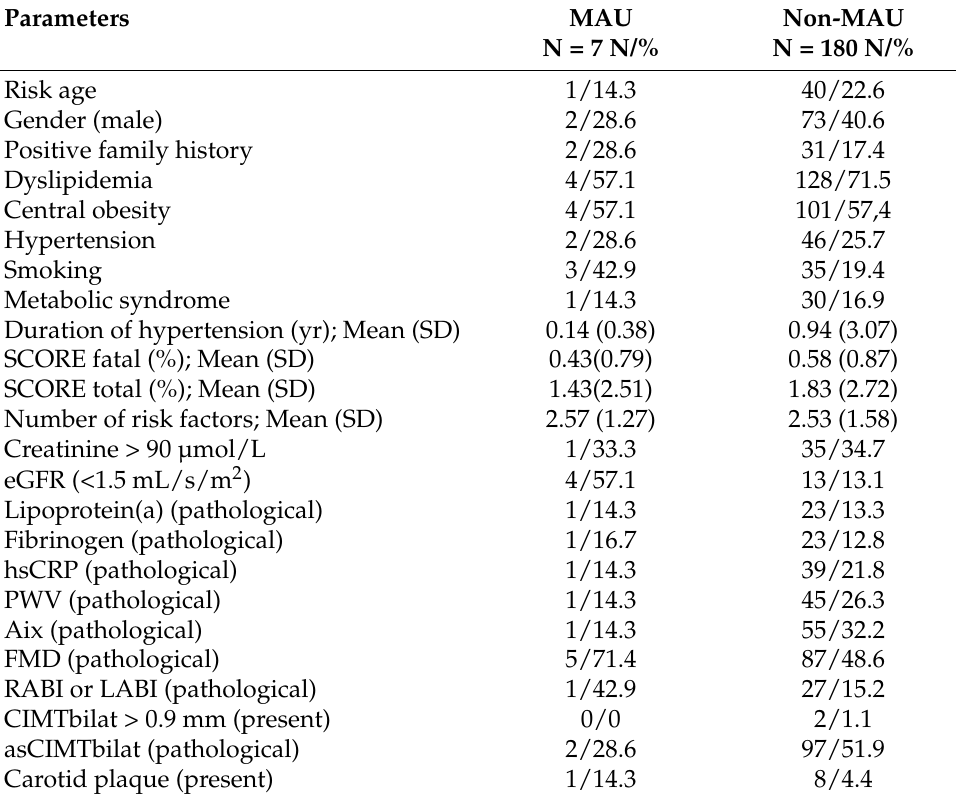
Table 3. Comparison of prevalence and mean values of variables related to cardiovascular risk profile between groups with and without microalbuminuria. No statistically significant differences were